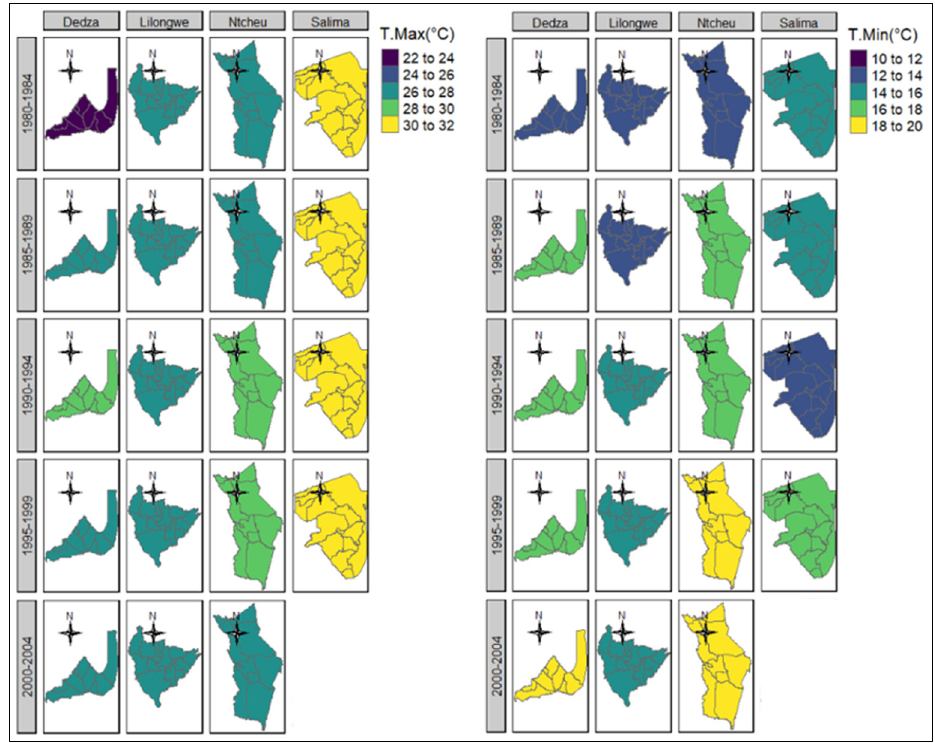
Figure 6. Temperature changes at 5-year intervals in the districts where meteorological stations are located in Malawi.